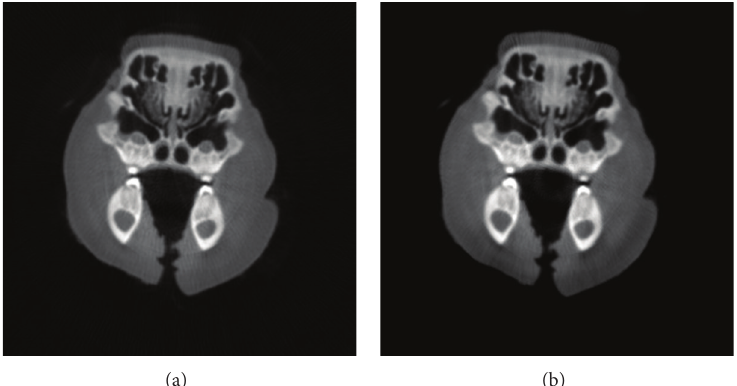
Figure 7: Transverse images of a pig’s head with projections collected using the TBCT benchtop system and reconstructed using the (a) FDK algorithm and (b) SART algorithm with MAS